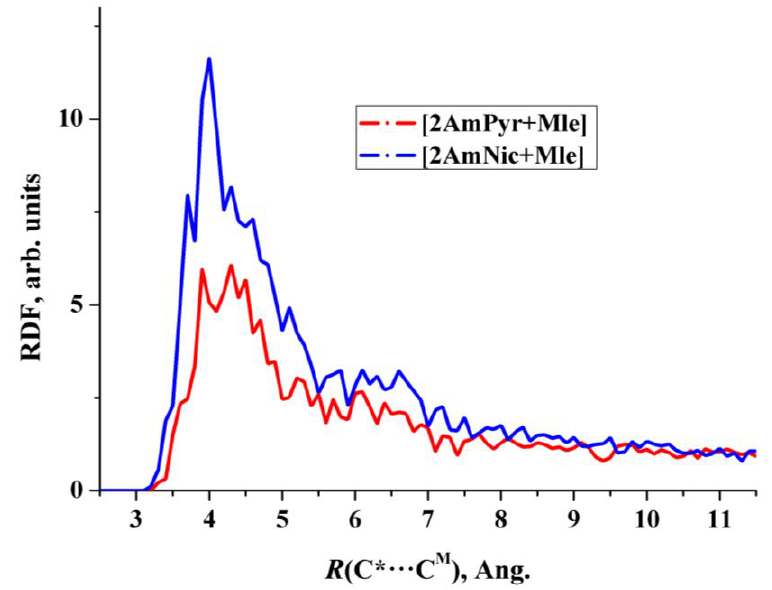
Figure 3. The radial distribution function (RDF) of the R[C* ··· C M ] distance obtained from the 100 ns NPT simulations.